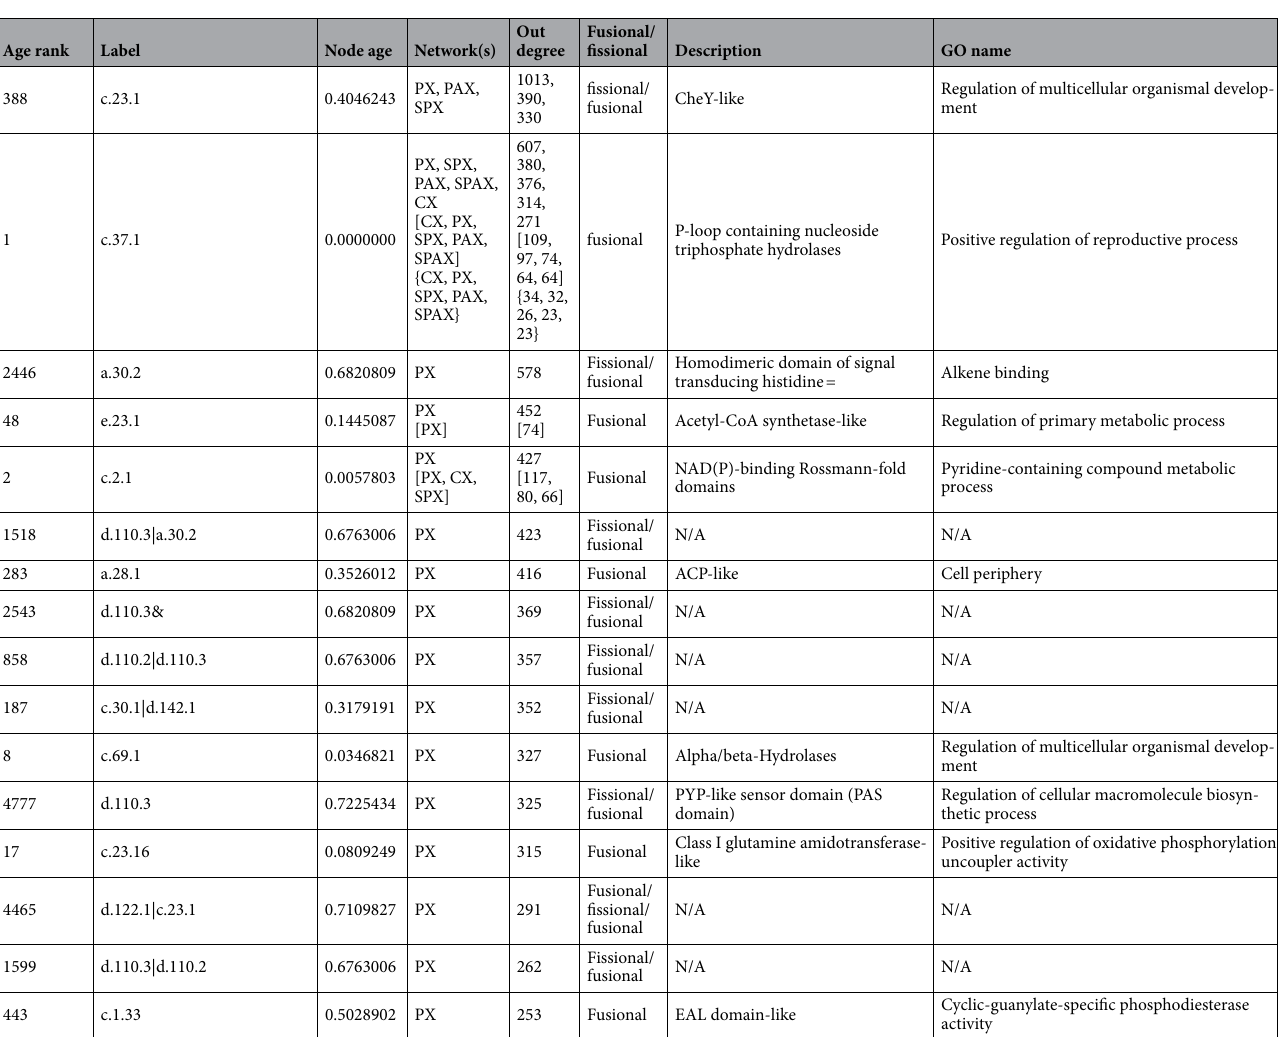
Table 1. Domains and domain combinations scoring > = 99.9th percentiles of 249.916, [63] and {23}, based on combined outdegrees of the five networks at time points 1.0, [0.676] and {0.671}, respectively. The square and curly brackets denote values from the events after and before the big bang, respectively. N/A, not